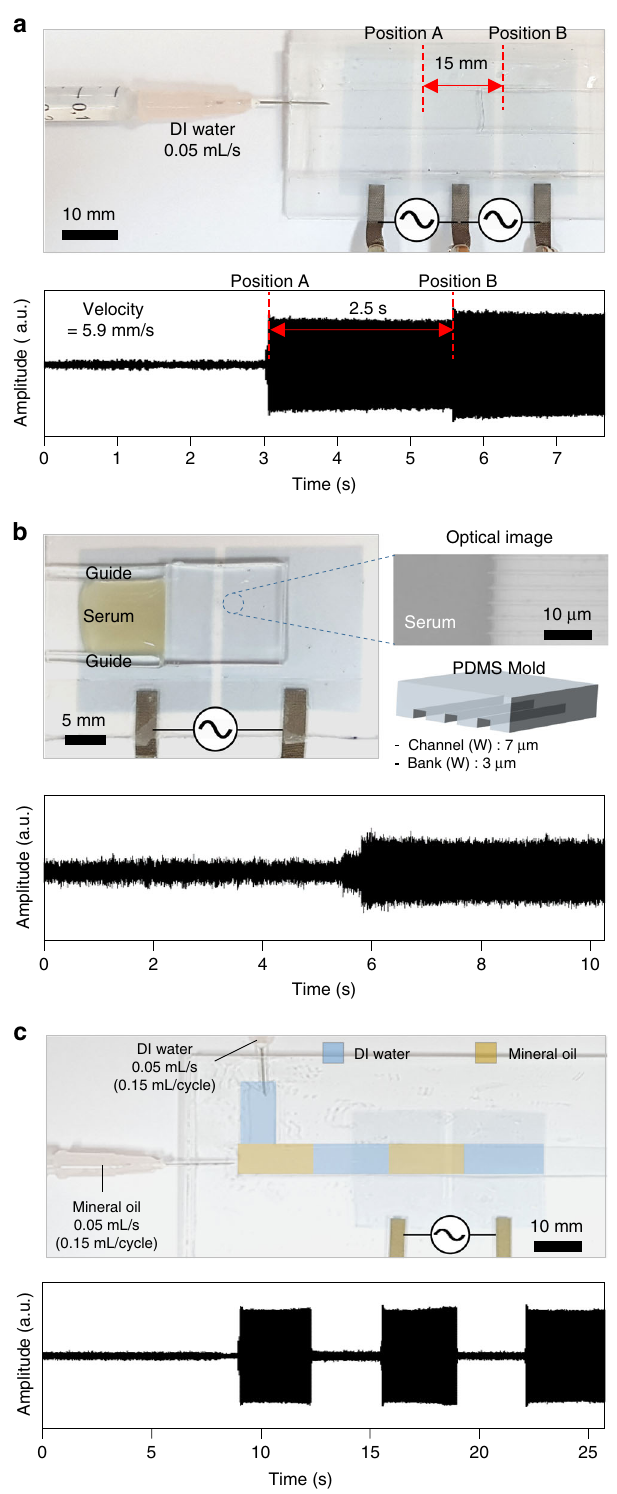
Fig. 6 Dynamic monitoring of liquids by liquid-interactive ferroelectric sound. a A photograph of an liquid-interactive ferroelectric sound (LIFS) alternative current (AC) device with three in-plane PEDOT:PSS